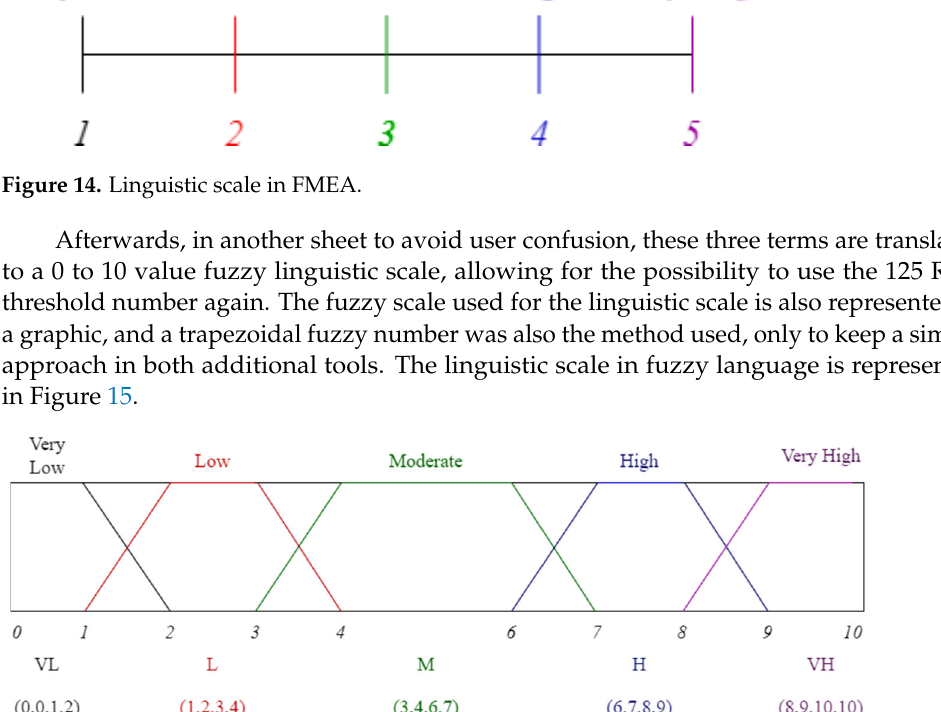
Table 2. Key client requirements. capacity to transport the desired load (1500 kg); capacity to list the loads to desired height (1.5 m); safe moving speed (3 km/h); allowed height (800 mm max); allowed width (1200 mm max); allowed length (2000 mm max); have a system to elevate loads; omnidirectional movement;